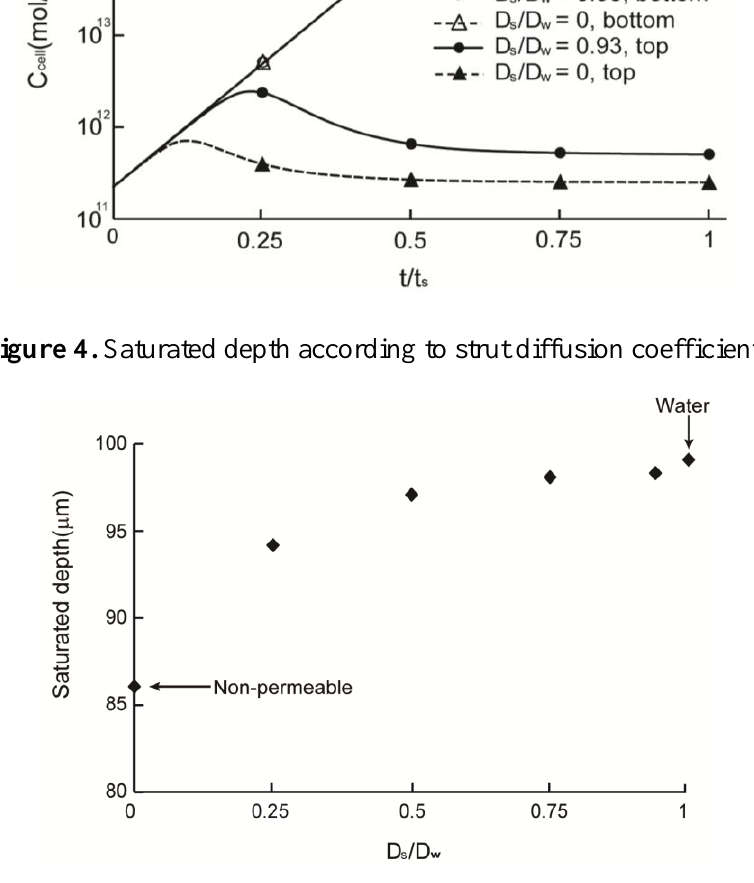
Figure 3. Time based simulation results for the quantity of cells in the various scaffold models. Two points (bottom and top) for electrospun line patterns ( D the non-diffusion strut model ( D